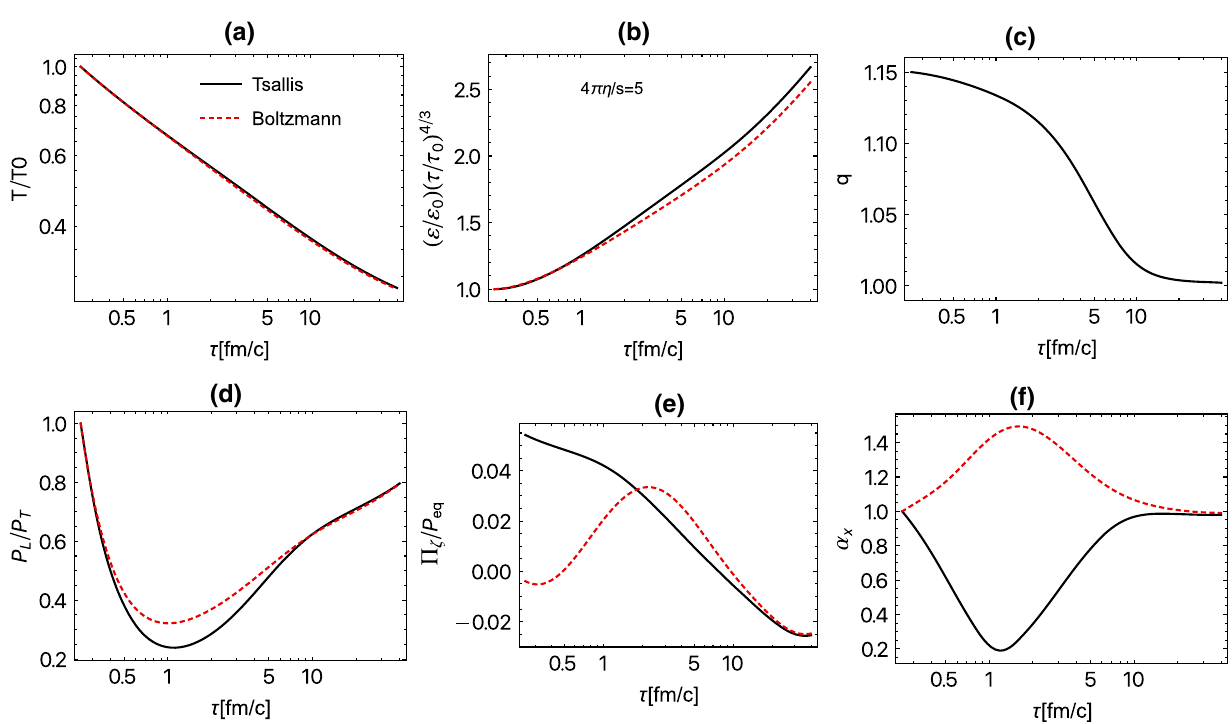
Fig. 2 Same as Fig. 1 with shear viscosity to entropy density ratio 4 πη/ s =